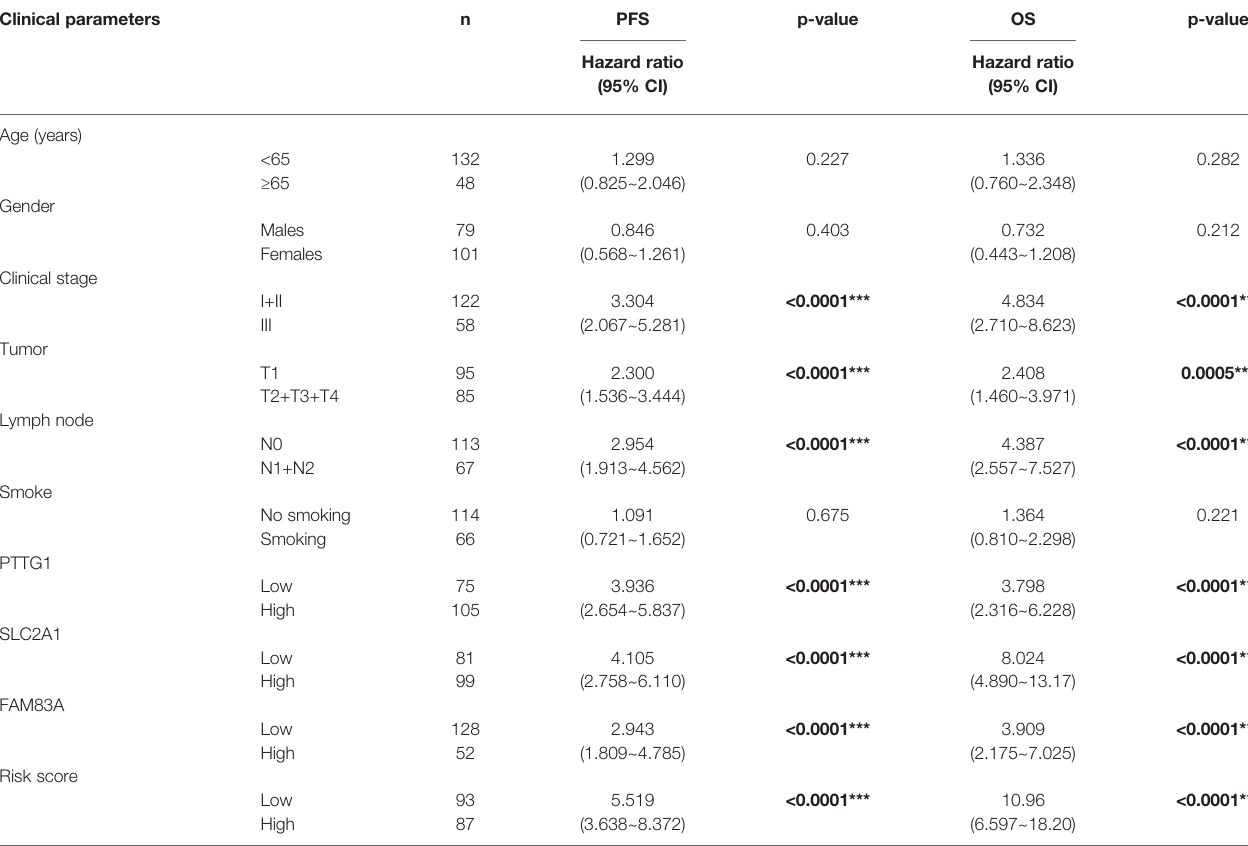
TABLE 2 | Univariate survival analysis of clinical parameters and the risk score with PFS and OS in the Tianjin cohort. Clinical